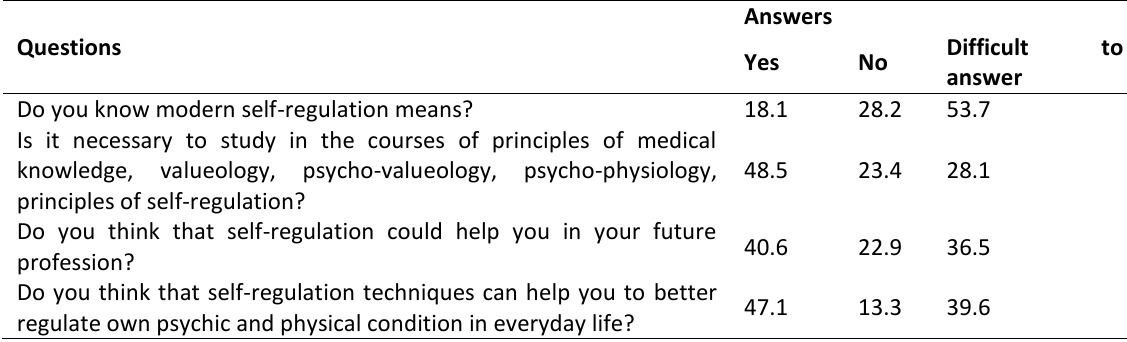
Table 1. Questioning results, %